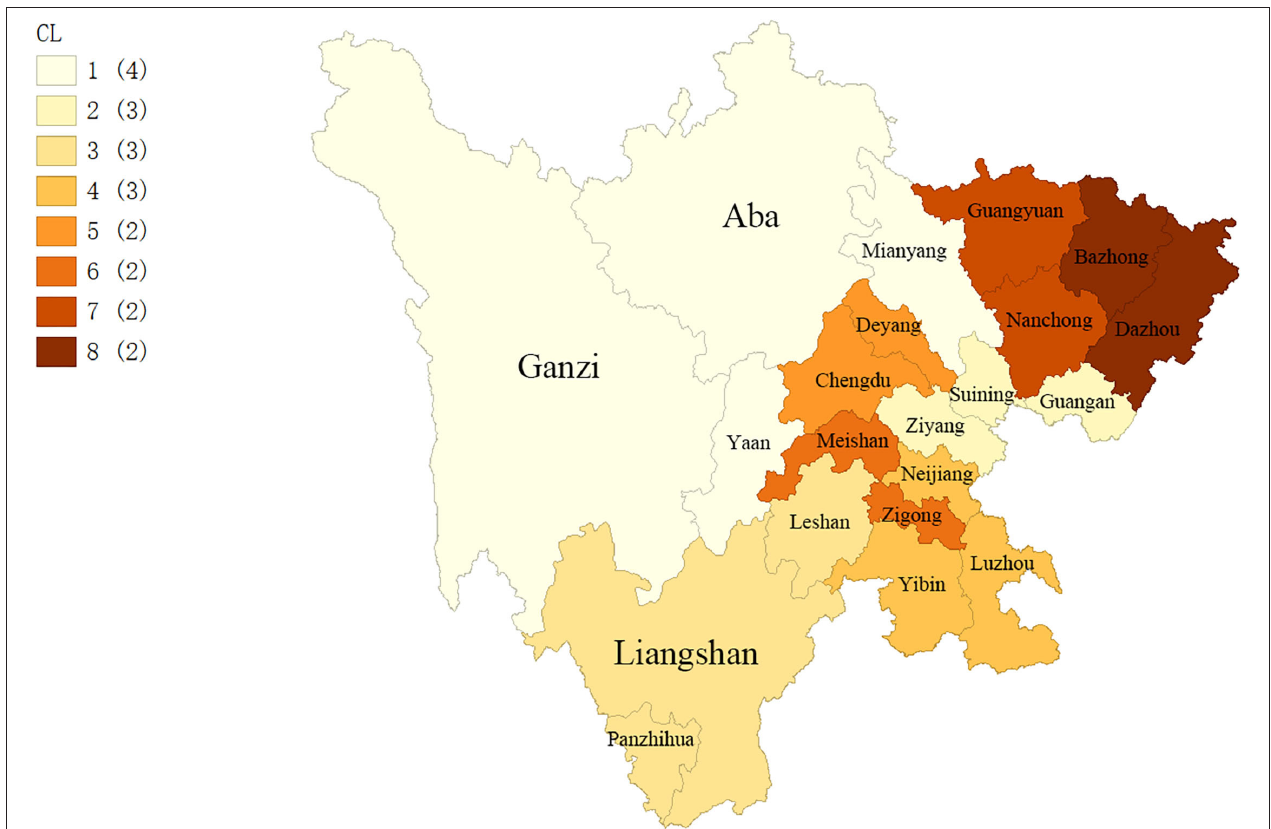
FIGURE 1 | The cluster results of spatial kluster analysis by tree edge removal (SKATER) algorithm.